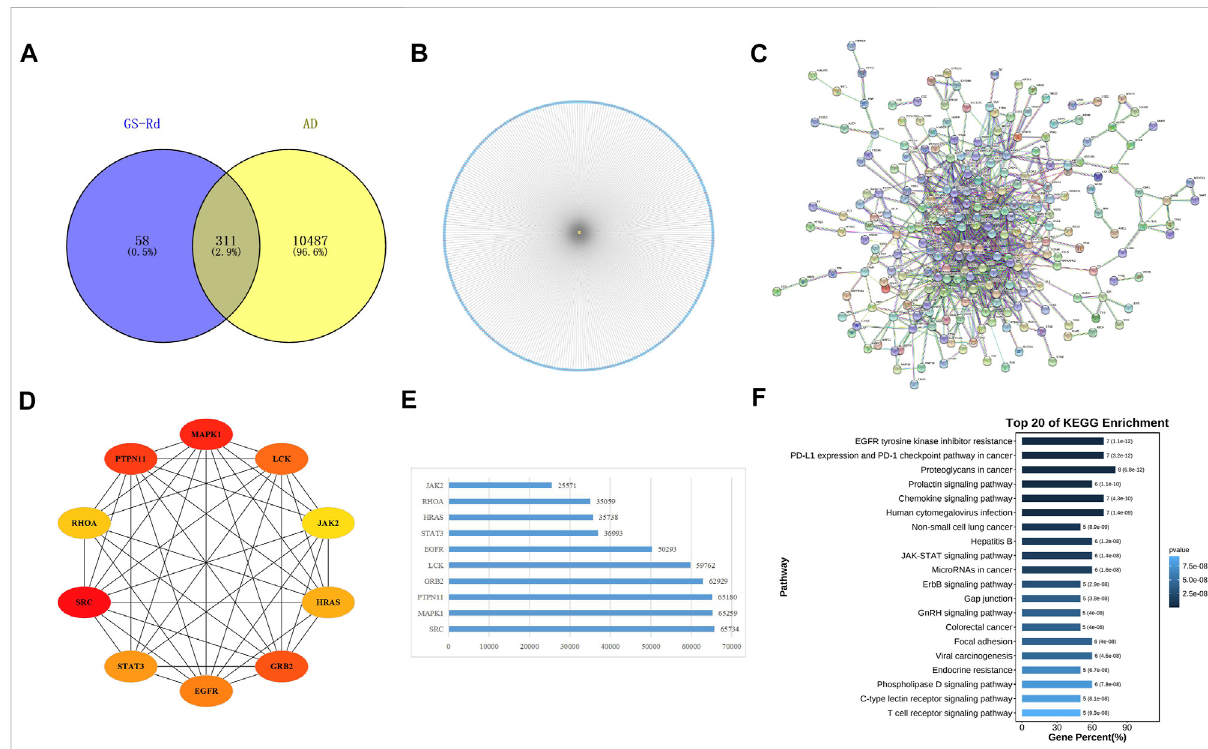
FIGURE 3 Targets genesanalysisofGS-Rd inregulatingAD. (A) Wayne diagramof GS-Rd andAD candidatetargets. (B) GS-Rd- targeting-ADnetwork. (C) The PPI network of potential targets of GS-Rd against AD. The “ node ” in the network represents the target protein, and the “ edge ” represents the interaction between the target proteins. Edges indicate the importance of the target protein corresponding to the node in the network. (D) The interaction diagram of the top 10 targets of GS-Rd against AD. (E) MCC calculates core target score statistics. (F) KEGG enrichment analysis of the core